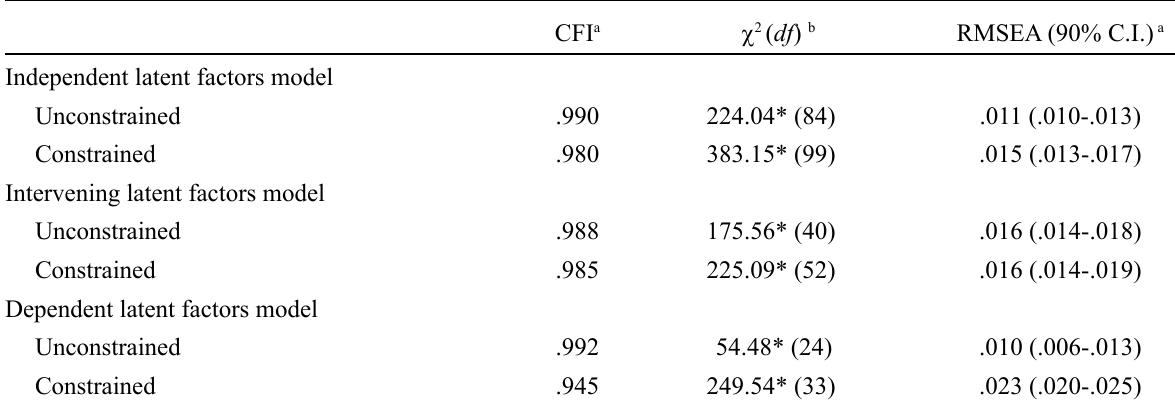
Measurement Models Fit Indexes for the Four Groups